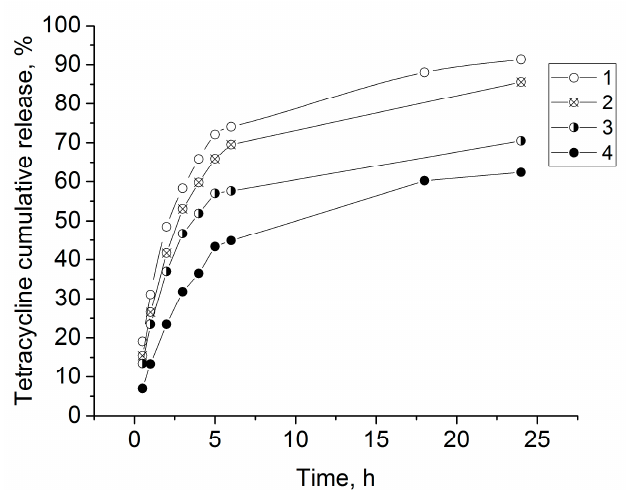
Figure 8. Tetracycline release kinetics from gels: 1—ALG, 2—ALG-CNW (2.5%), 3—ALG-CNW (7.5%), 4—ALG-CNW (14.5%).